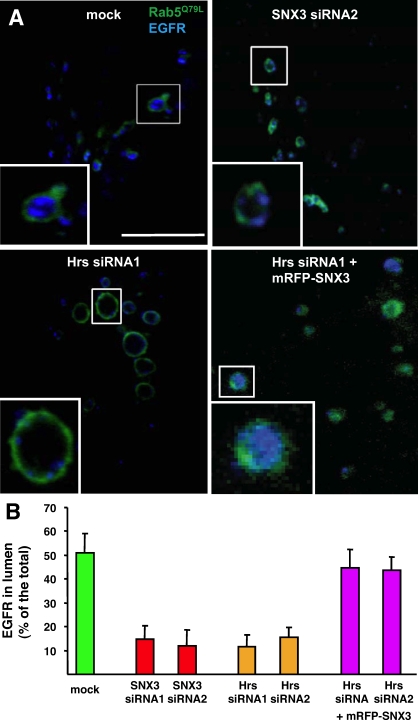
SNX3 Controls the Formation of Intralumenal Vesicles That Incorporate the EGF Receptor(A and B) HeLa cells were mock-treated or treated with siRNAs against SNX3 or Hrs (two different siRNAs in each case) and transfected with GFP-Rab5Q79L (green) during the last 24 h. Alternatively, mRFP-SNX3 was overexpressed in cells treated with each anti-Hrs siRNA. After cell surface binding, EGF was internalized for 15 min at 37 °C. Cells were labeled with anti-EGF-R antibodies (blue) and analyzed by confocal microscopy. In (B), the relative amount of EGF-R in the lumen of endosome was quantified [50] and expressed as the percentage of the total amount of EGF-R. Each condition is the mean of at least three independent experiments; standard errors are indicated. (A) Scale bar indicates 10 μm. Insets in the lower left are a magnification of the regions shown in the boxes.